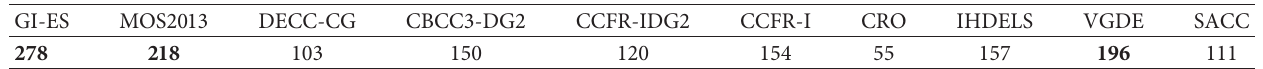
Table 8: Ranks of 18 algorithms using CEC2010 according to FOS (the top three are in bold). GI-ES EADE ANDE 94 Table 9: Ranks of 10 algorithms using CEC2013 according to FOS (the top three are in bold). GI-ES